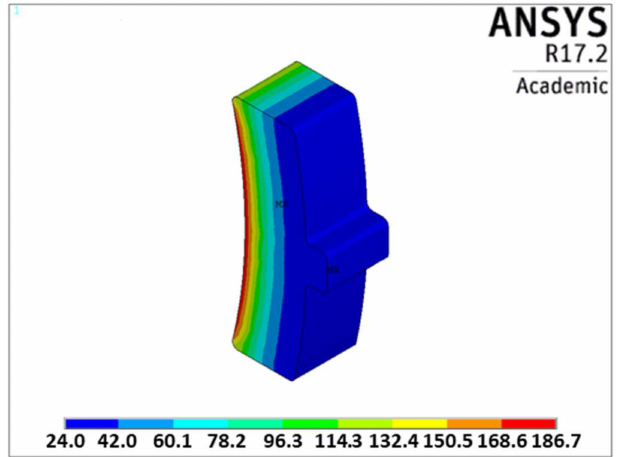
Figure 4. Braking maneuver A—Temperature of the brake block at the end of the brake maneuver.